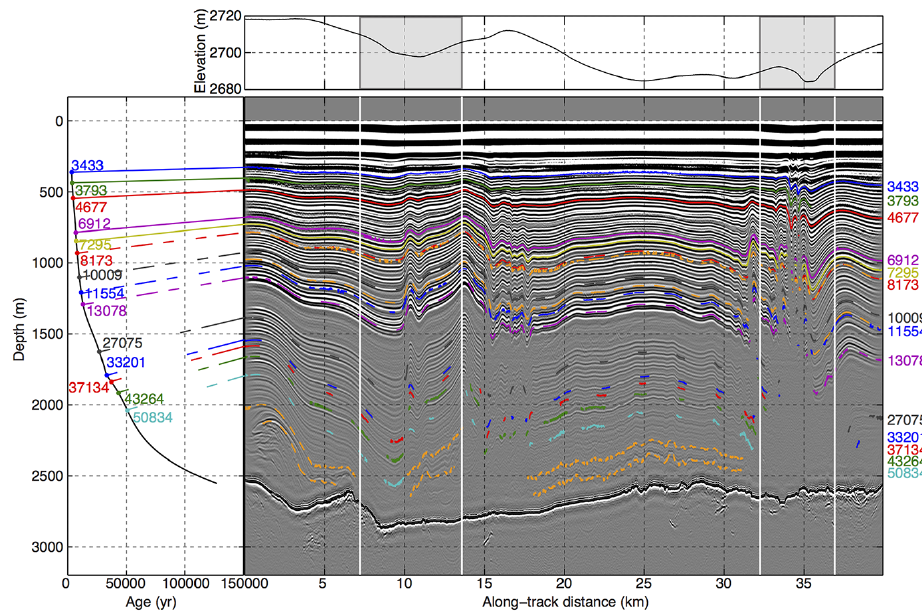
Figure 6. Profile a–a’ (from Fig. 4) with dated internal layers. Age scale is assigned by tracing internal layers dated in the NGRIP core from NGRIP to NEGIS in airborne RES. Surface topography is from kinematic GPS data.